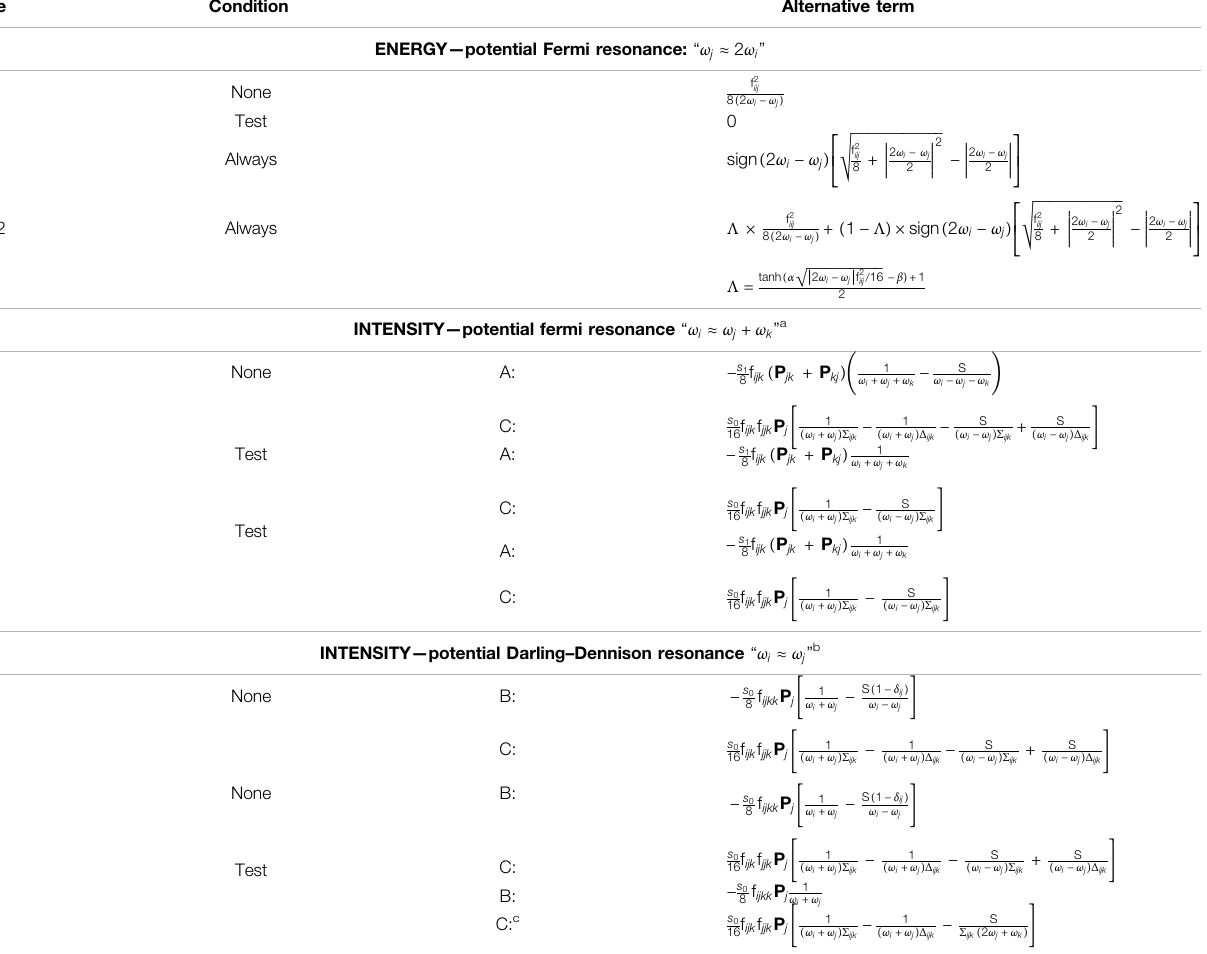
TABLE 1 | Description of the treatment of Fermi resonant terms in the calculation of energy, and Fermi and Darling – Dennison resonance in intensities for some VPT2 schemes. The condition indicates in which cases the alternative term is used in place of the potentially resonant term (reported for the original VPT2 scheme since no transformation is done). See text for details. Σ ijk (cid:1) ω i + ω j + ω k and Δ ijk (cid:1) ω i − ω j − ω k .